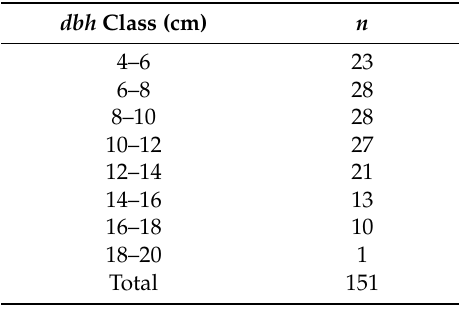
Table A2. Number of trees ( n ) per diametric class in clone A group at two and three years of age, simultaneously.